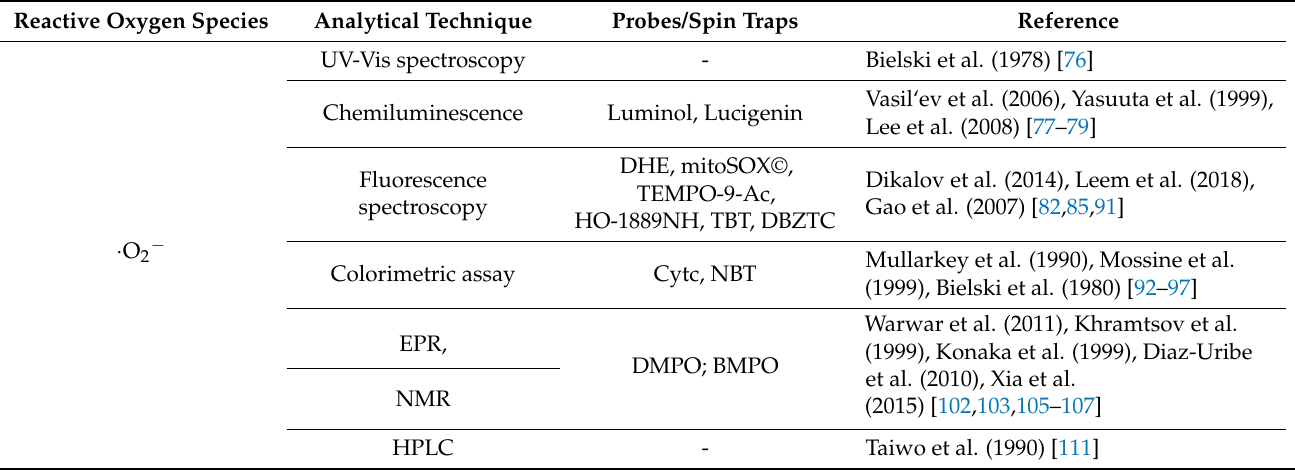
Table 2. Analytical techniques/assays to detect superoxide anions with the corresponding probes or spin traps and relevant